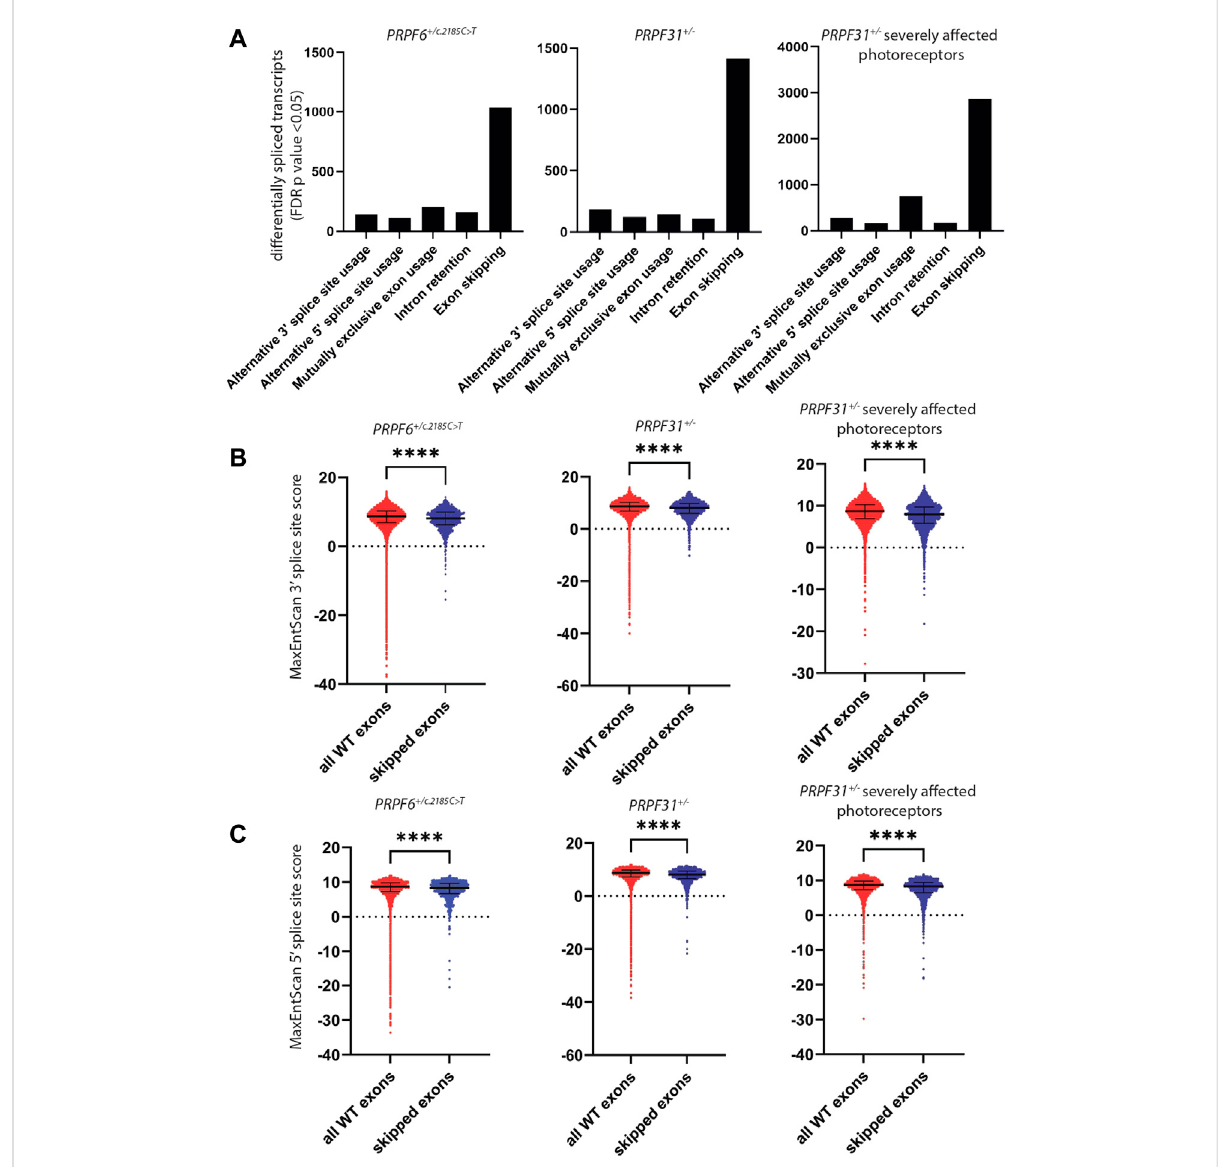
FIGURE 3 Analysis of differentially splicedtranscripts and splice sites in PRPF6 +/c.2185C > T cells, PRPF31 +/ − cells and retinal organoids derived from PRPF31 +/ − patients severely affected with RP. (A) Bar chart showing the number of cases of statistically signi fi cant (FDR p < 0.05) alternative 3 ′ splice site usage, alternative 5 ′ splice site usage, mutually exclusive exon usage, intron retention and exon skipping in PRPF6 +/c.2185C > T cells, PRPF31 +/ − cells and retinal organoidsderivedfrom PRPF31 +/ − patientsseverelyaffectedwithRPcomparedtorelevantcontrols,showingtheabundanceofexonskippingin all 3 cell/organoid types. (B) Dot plots showing MaxEntScan 3 ′ splice site score for every wild-type exon and every skipped exon identi fi ed in (A) , showing that skipped exons have lower 3 ′ splice site scores, i.e., weaker 3 ′ splice sites are skipped in PRPF6 and PRPF31 mutant cells. Individual data points plus median and interquartile range are shown **** p < 0.0001 Mann-Whitney in all cases. PRPF6 3 ′ WT median 8.680, SE media 8.150 n = 1039, PRPF31 3 ′ WT median 8.670, SE media 8.110 n = 1419, PRPF31 retinal organoids 3 ′ WT median 8.680, SE media 7.900 n = 2866. (C) Dot plots showing MaxEntScan 5 ′ splice site score for every wild-type exon (red) and every skipped exon (blue) identi fi ed in (A) , showing that skipped exons have lower 5 ′ splice site scores, ie weaker 5 ′ splice sites are skipped in PRPF6 and PRPF31 mutant cells. Individual data points plus median and interquartile range are shown **** p < 0.0001 Mann-Whitney in all cases. PRPF6 5 ′ WT median 8.700, SE median 8.345 n = 2866, PRPF31 5 ′ WT median 8.680, SE median 8.100 n = 1419, PRPF31 retinal organoids 5 ′ WT median 8.690, SE median 8.310 n =